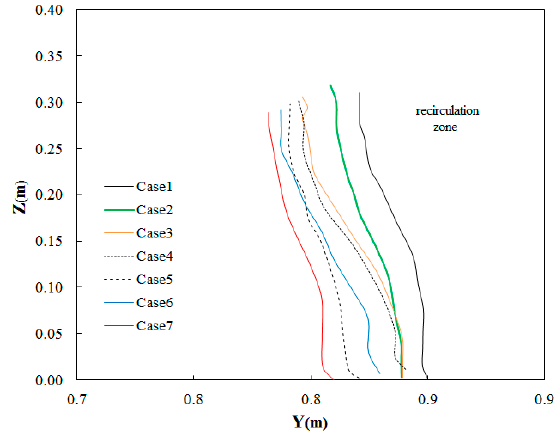
Figure 10. Transverse profile of recirculation zone at x = 8.35 (x = 0.5 Wc downstream of confluence).